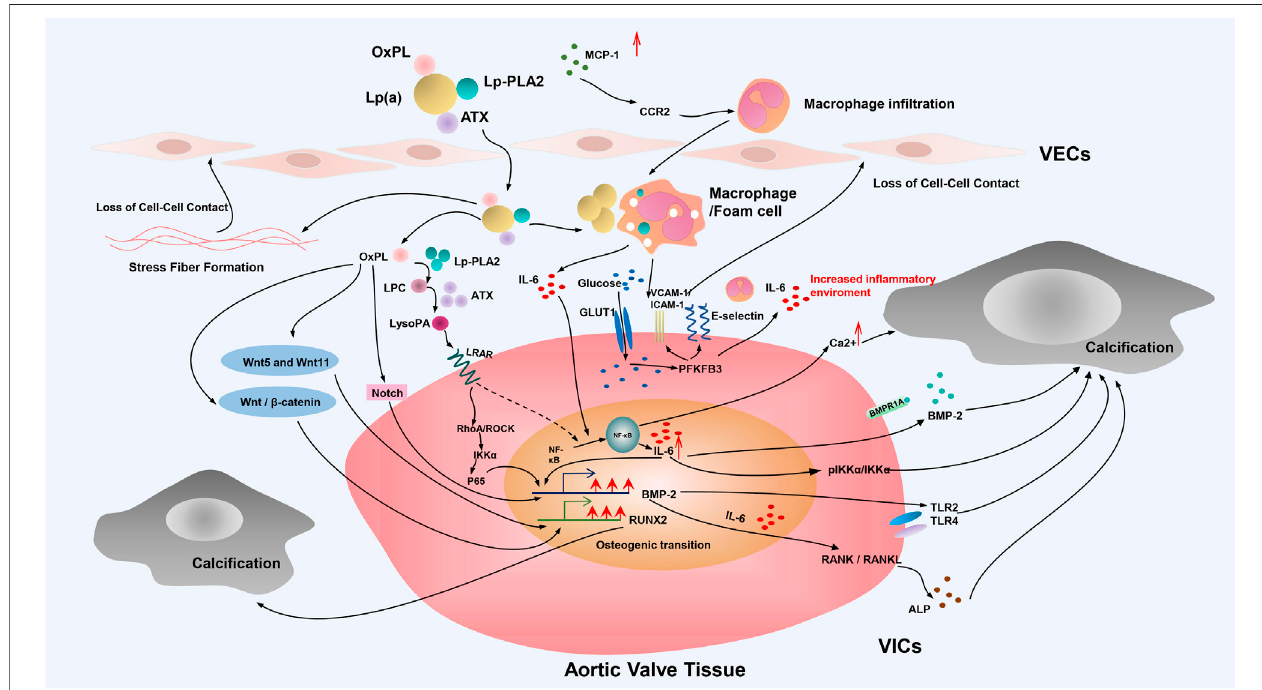
FIGURE 2 | Mechanisms of Lp(a)-induced CAVD. Schematic diagram depicts the mechanism of Lp(a)-induced CAVD. The main pathophysiological processes involving Lp(a) in CAVD include endothelial dysfunction, indirect promotion of foam cell formation through OxPL, valvular calci fi cation and so on. Valvular calci fi cation of VICsplaysanimportantroleintheoccurrenceanddevelopmentofLp(a)-mediatedCAVD.ThisprocessofphenotypictransformationismainlyincludingtheNotchsignal pathway and NF- κ B receptor activator pathway, and is also partially mediated by in fl ammation, oxidative stress, and the Wnt signal pathway. OxPL, oxidized phospholipids; Lp(a), lipoprotein (a); ATX, autotaxin; Lp-PLA2, lipoprotein-associated phospholipase A2; MCP-1, monocyte-macrophage chemoattractant protein-1; CCR2, C-C chemokine receptor type 2; LPC, lysophosphatidylcholine; LysoPA, lysophosphatidic acid; LPAR, lysophospholipid receptor; GLUT1, glucose transporter type 1; VCAM-1, vascular cell adhesion molecule-1; ICAM1-1, intercellular adhesion molecule-1; IL-6, interleukin 6; BMP-2, bone morphogenetic protein-2; IKK α , IkappaB kinase-alpha; TLR,; Toll-like receptor; VECs, endothelial cells; VICs, valvular interstitial cells.